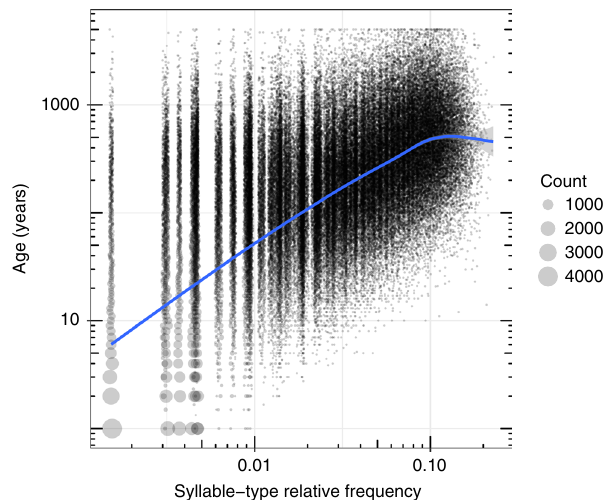
Fig. 4 Age of syllable types in fi tted simulations. The age of syllable types in the 1000 simulations that best fi t the empirical data. Each point represents a combination of age in years since the syllable type was innovated and frequency within the population (point size represents the number of times that combination arose). More common syllable types tended to be older, and many syllable types are estimated to be older than 500